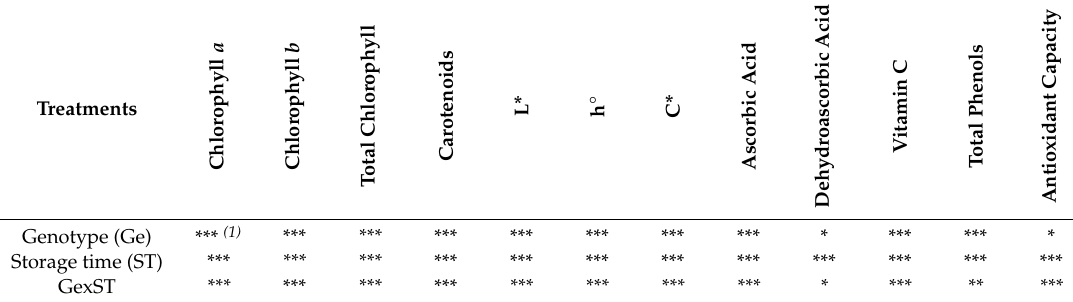
Table 5. E ff ect of genotype and cold storage time on the visual and anti-oxidative traits of broccoli florets.